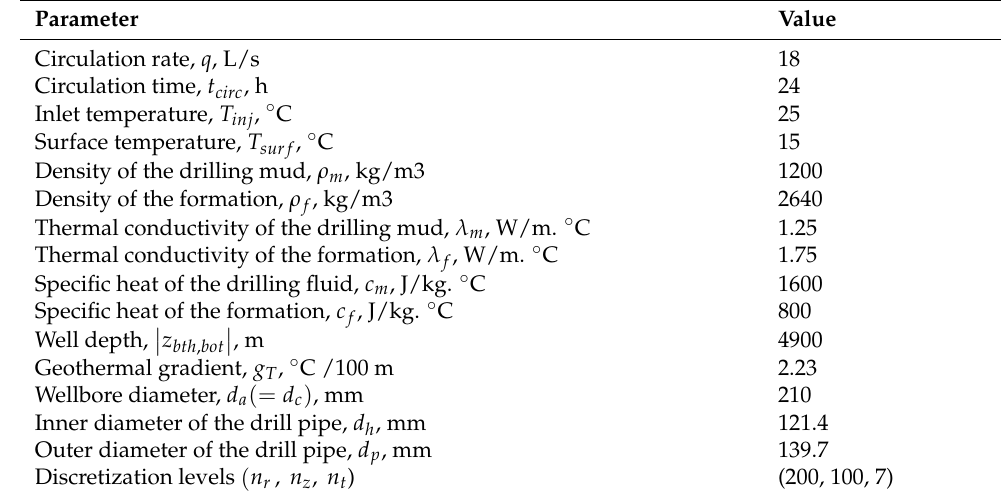
Table 1. Parameters of drilling operation and formation.